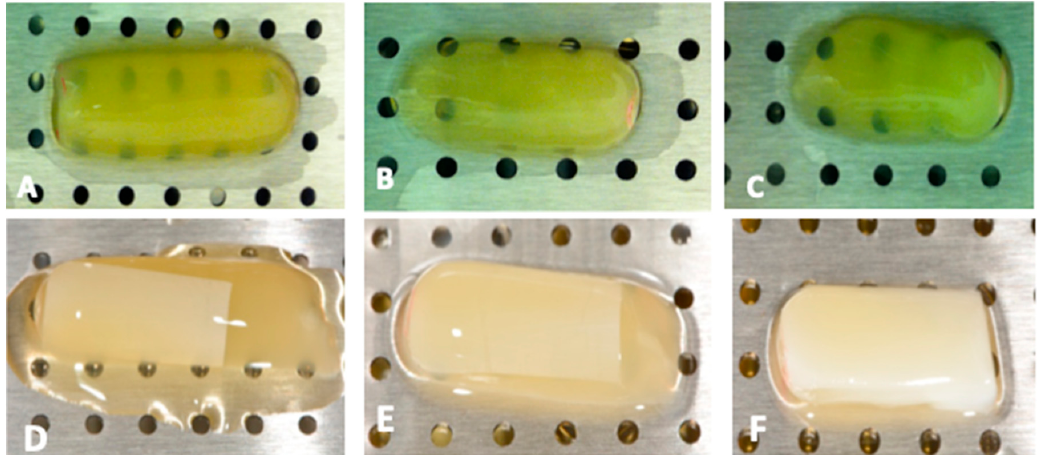
Figure 2. Fibrin alone (top row) and hybrid PCL-fibrin membranes (bottom row) immediately after